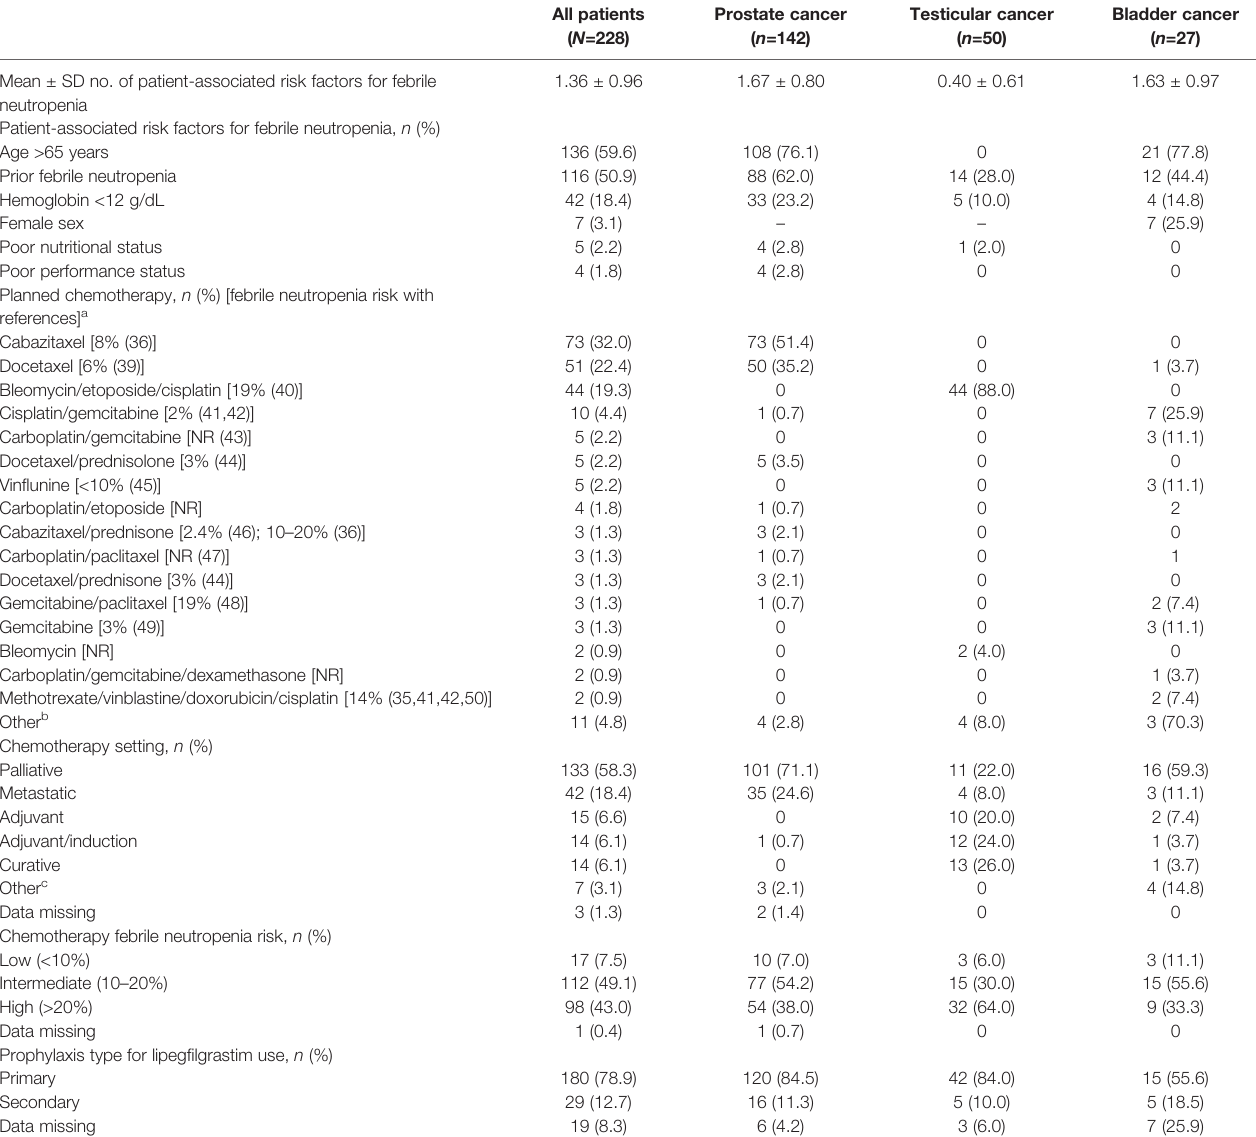
TABLE 3 | Neutropenic risk, chemotherapies, and prophylaxis type.